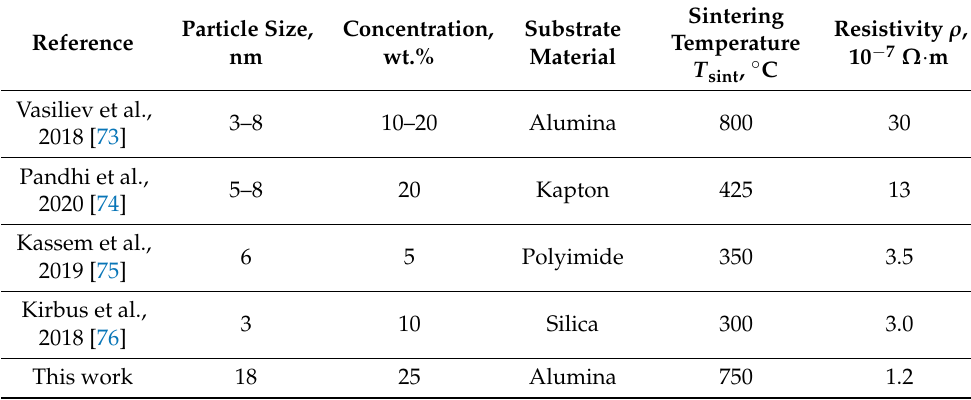
Figure 11. Dependence of the resistivity of platinum lines on T sint and the corresponding SEM images of the surface of the sintered lines (inset). Table 3. Comparison of parameters of platinum